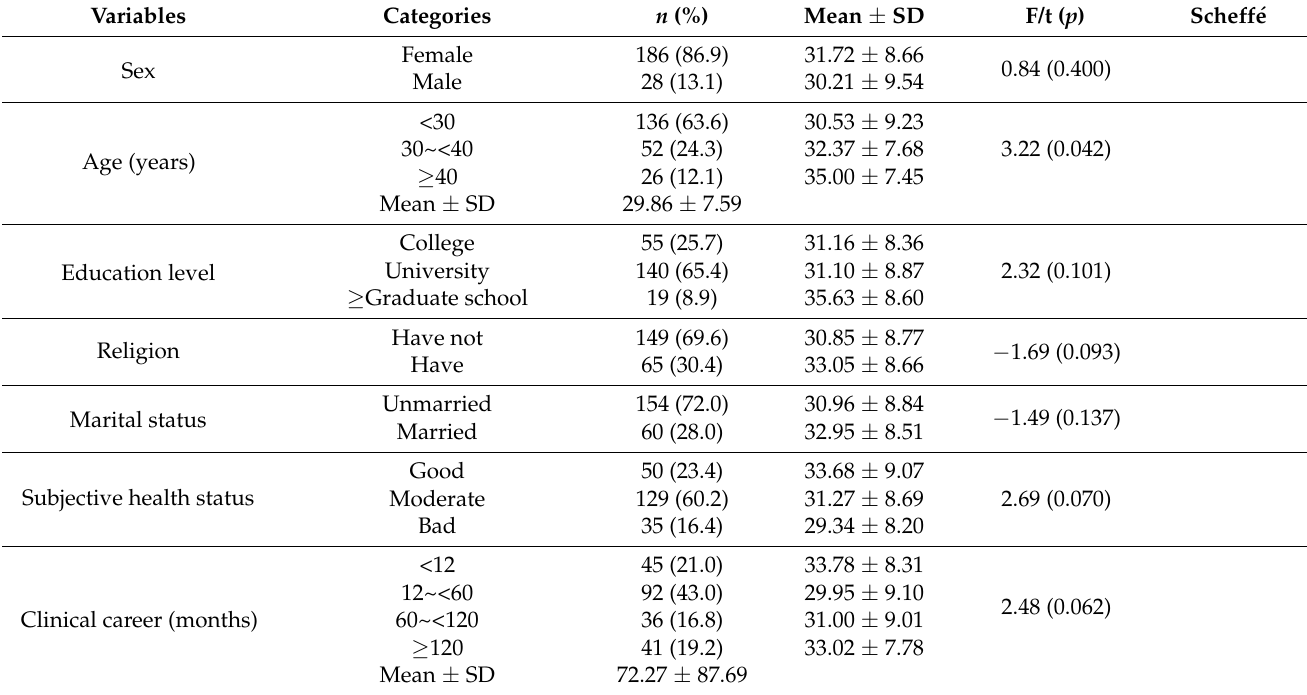
Table 1. General characteristics of subjects, degree of variables, and differences in retention intention according to general characteristics (N =